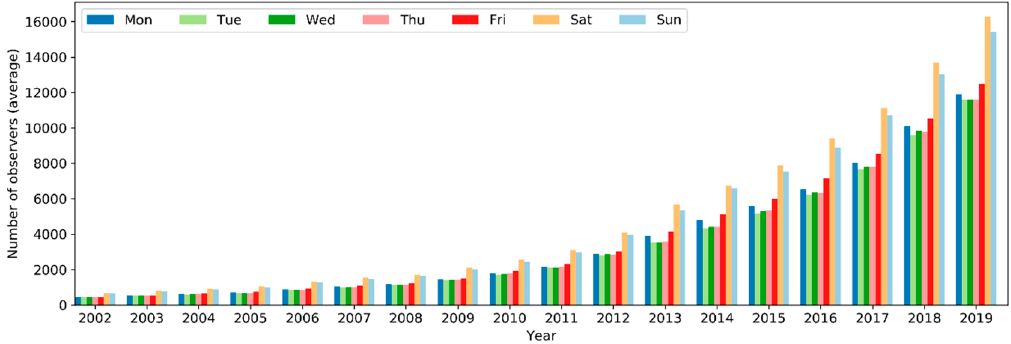
Figure 12. Average number of active observers on each day of the week over the years.